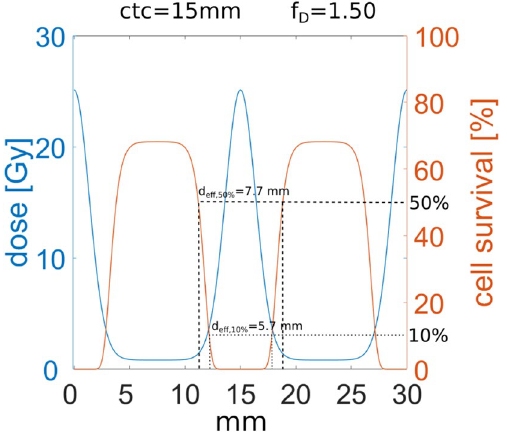
Figure 8. Dose profile (blue) and cell survival profile (orange) for 2-dir planar minibeams with ctc = 15 mm at 9 cm depth (2-Gaussian approximation). The dotted lines mark the biologically effective beam size with a 10% survival threshold (d eff,10% ). The dashed lines mark the biologically effective beam size with a 50% survival threshold (d eff,50% ). A ctc of 15 mm was found to deliver an optimum mean cell survival even though the mean dose has to be increased by the factor f D =